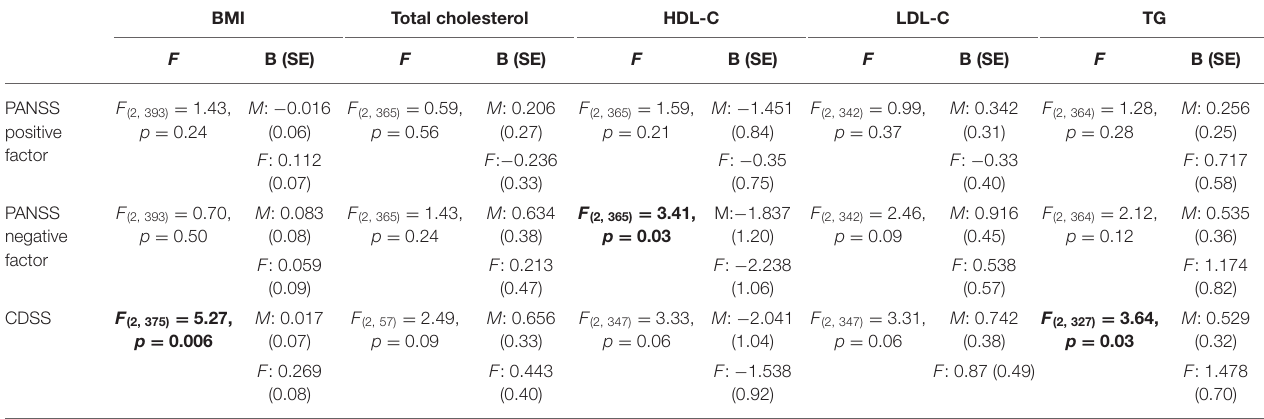
TABLE 2 | Regression analyses examining sex-related association between metabolic measures and psychotic symptoms. BMI Total cholesterol HDL-C